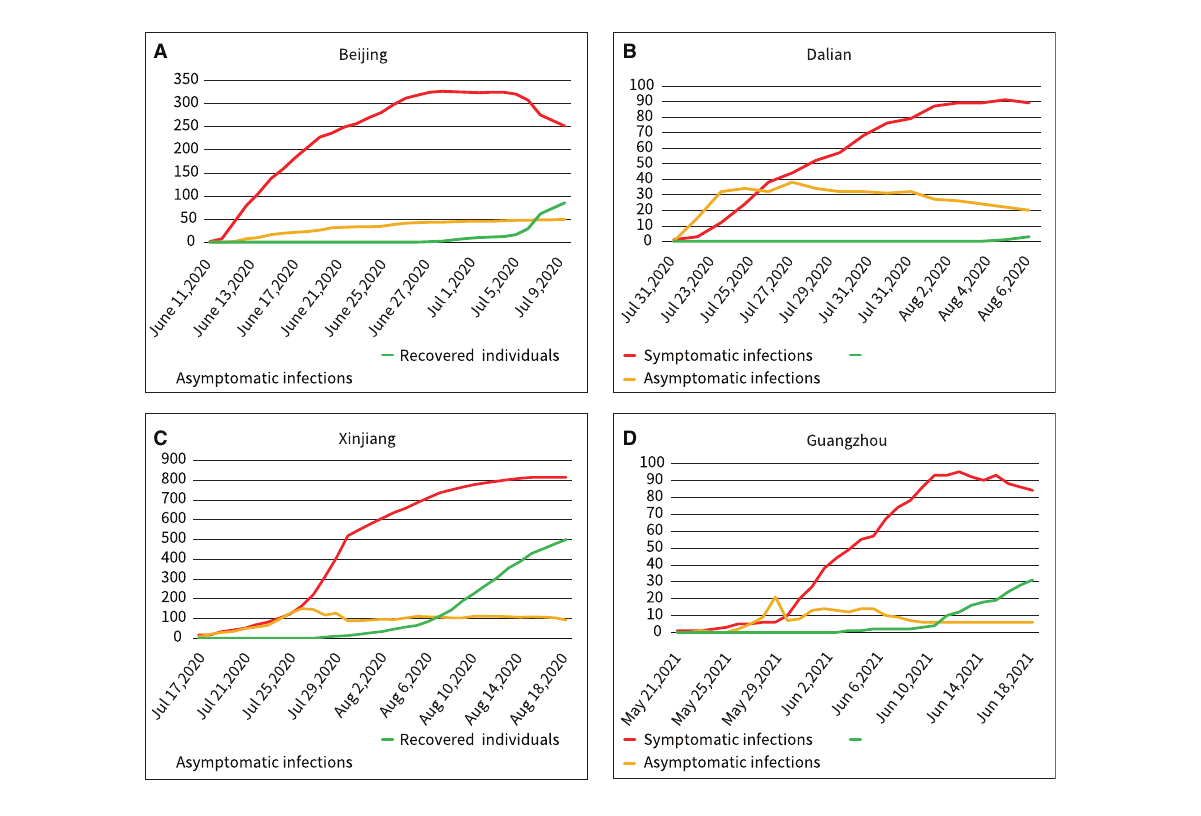
FIGURE2 Outbreaks in the four regions include asymptomatic infections and symptomatic infections, and recovered individuals. (A) Beijing, (B) Dalian, (C) Xinjiang, (D) Guangzhou.